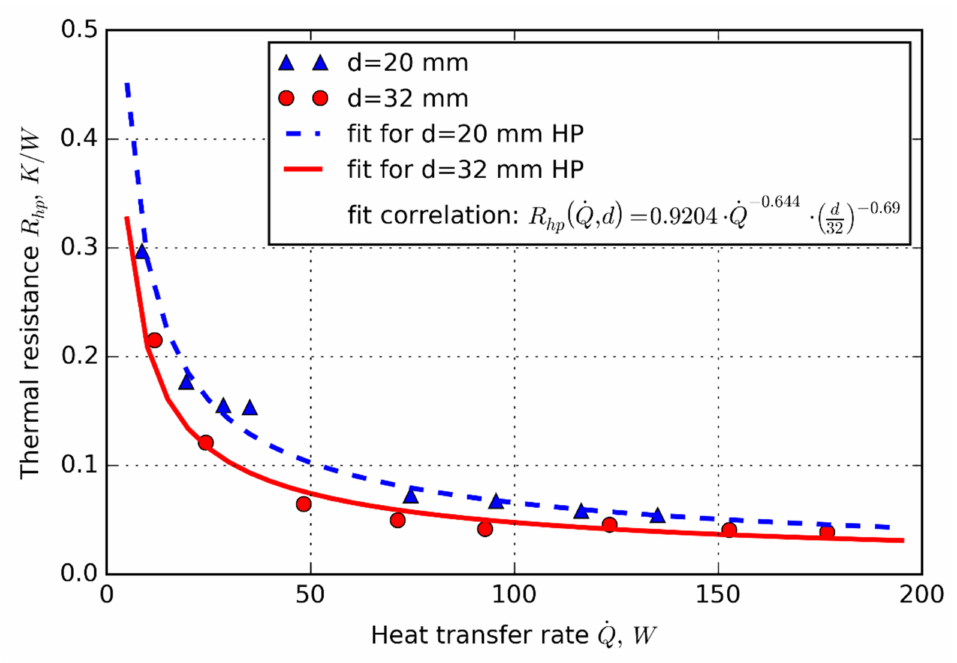
Figure 4. Thermal resistance vs. heat transfer rate for 20% filling ratio, for d = 20 mm, and d = 32 mm HP. Experimental data were fitted with (25)